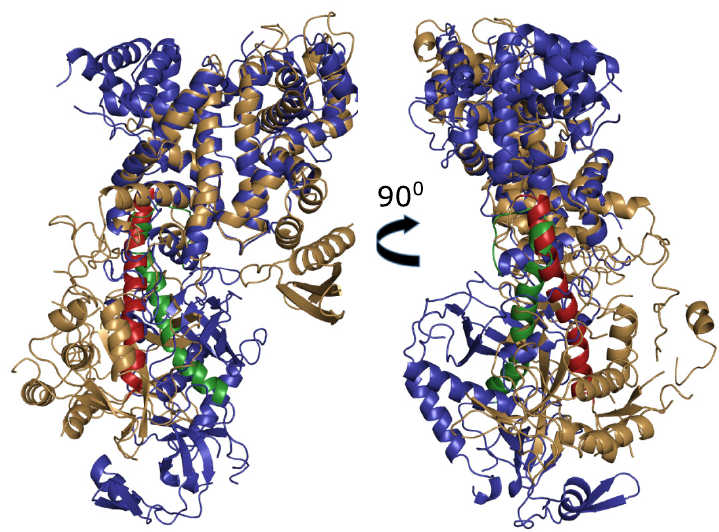
Fig 2. Superimposition of Drosha and Dicer. Front (left) and side (right) views of superimposition of Drosha (sand) upon Dicer (deep blue). Connector domain of Drosha is colored firebrick and of Dicer green-forest. Starting at the C- terminus of the Connector helix Drosha has more stooped posture compared with Dicer. The distance between the N- terminal of both Connector domains is 20.21 Å , and the bending angle is